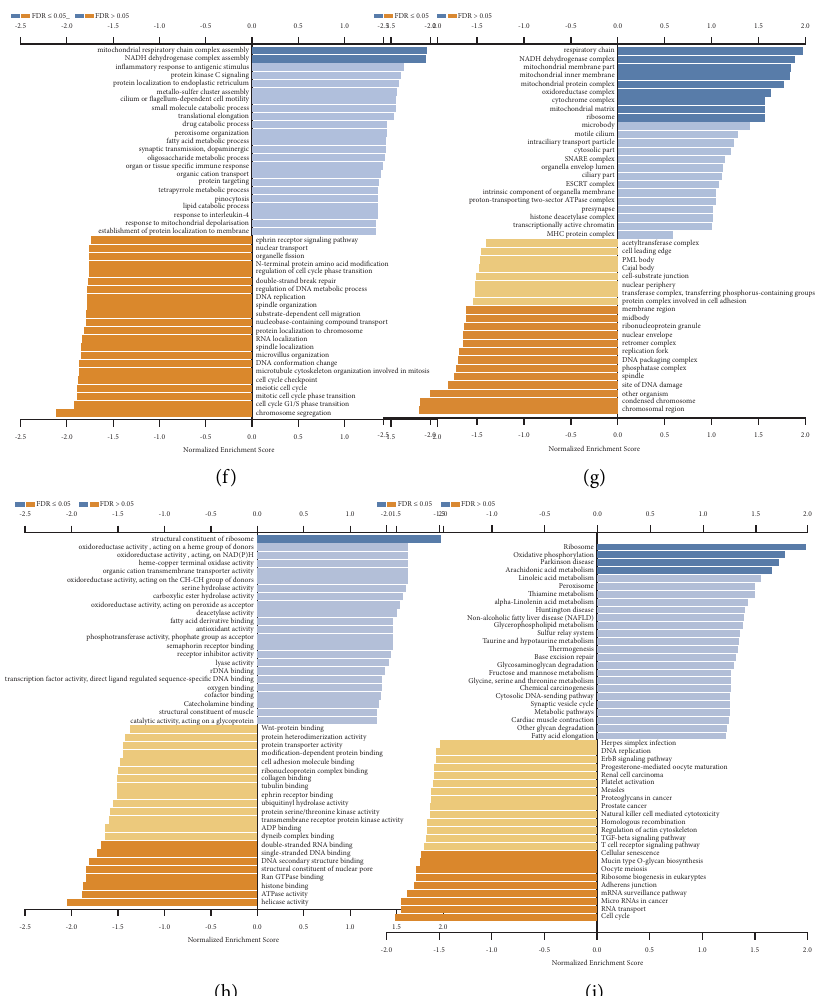
Figure 9: Te coexpression genes with MYL5 of BRCA patients in the LinkedOmics database. (a) Te whole obviously correlated genes with MYL5 distinguished by the Pearson test in BRCA. (b) and (c) Top 50 genes positively and negatively correlated with MYL5 in BRCA were respectively displayed by the heatmap. (d) and (e) Survival map of the top 50 genes negatively and positively associated with MYL5 in BRCA. (f–i) GO analysis (biological process), GO analysis (molecular function), GO analysis (cellular component), and KEGG pathways of MYL5 in BRCA